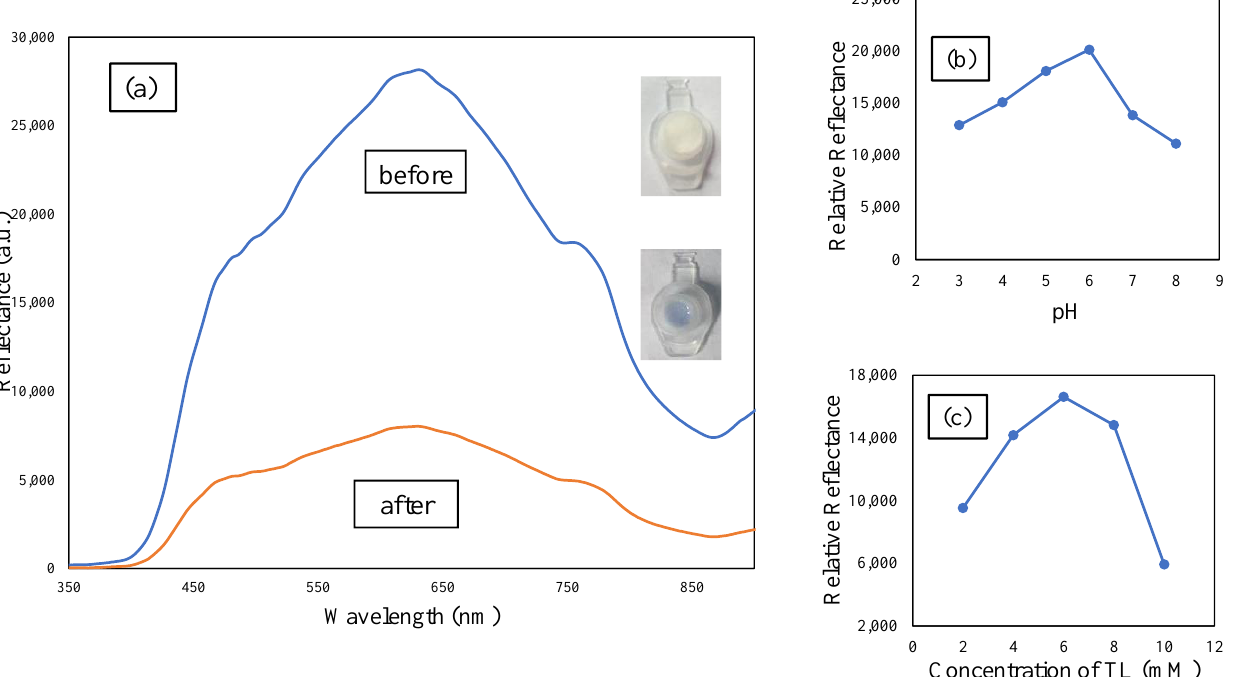
Figure 4. ( a ) Spectra of reflectance intensity before and after the deposition of Cu 2+ ion onto the TL–SBA15 microsphere; ( b ) effect of pH; and ( c ) effect of TL concentration on the reflectance of the Cu 2+ ion sensor response.